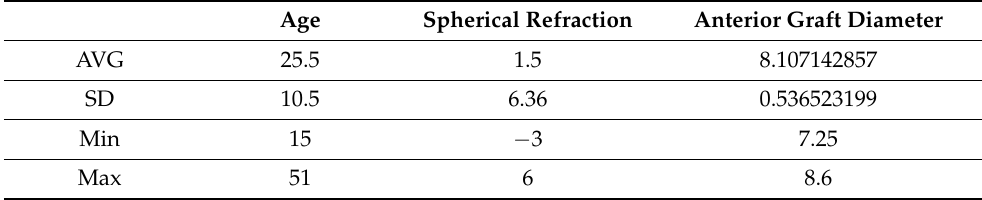
Table 1. Patient data before keratoplasty, including their age, refraction, and graft